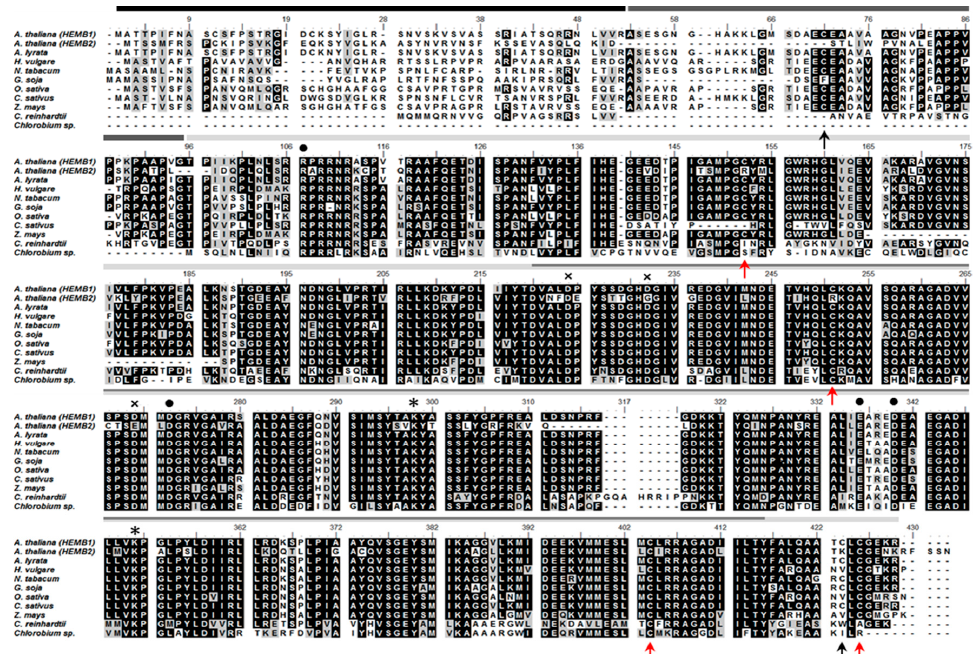
Figure 2. Alignment of the ALAD of different plant species ( Arabidopsis thaliana ALAD encoded by HEMB1 and HEMB2 , Arabidopsis lyrata , Hordeum vulgare , Nicotiana tabacum , Glycine soja , Oryza sativa , Cucumis sativus , Zea mays ), Chlamydomonas reinhardtii and Chlorobium vibriforme . The six cysteines of the mature A. thaliana protein are highlighted with arrows (red arrows indicate the four conserved cysteines in higher plants). The different domains are annotated by structure prediction (ChloroP, Basic Local Alignment Search Tool (BLAST)). M1-R52: chloroplast transit peptide; A53-G95: